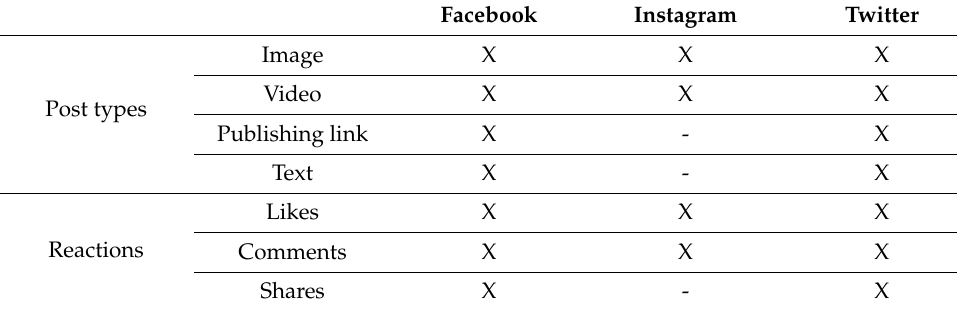
Table 1. Post types by social media.